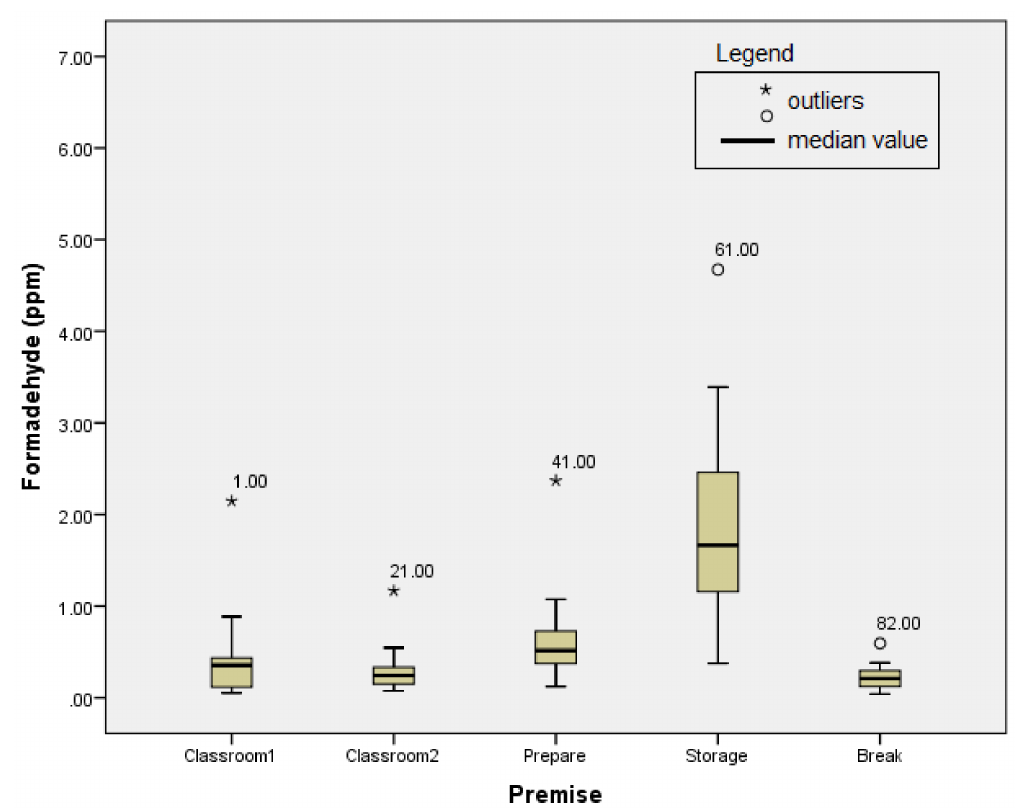
Figure 1. The results of the first sampling campaign.